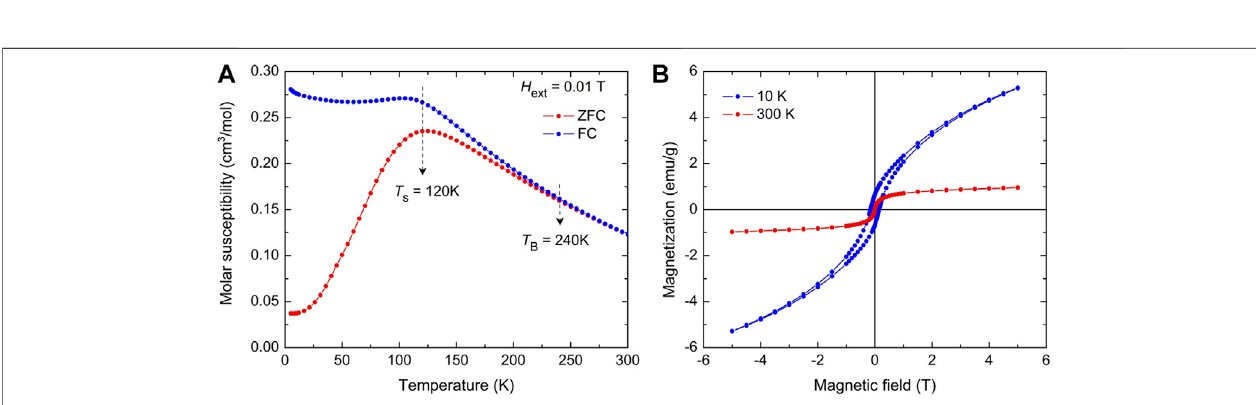
Frontiers in Chemistry |